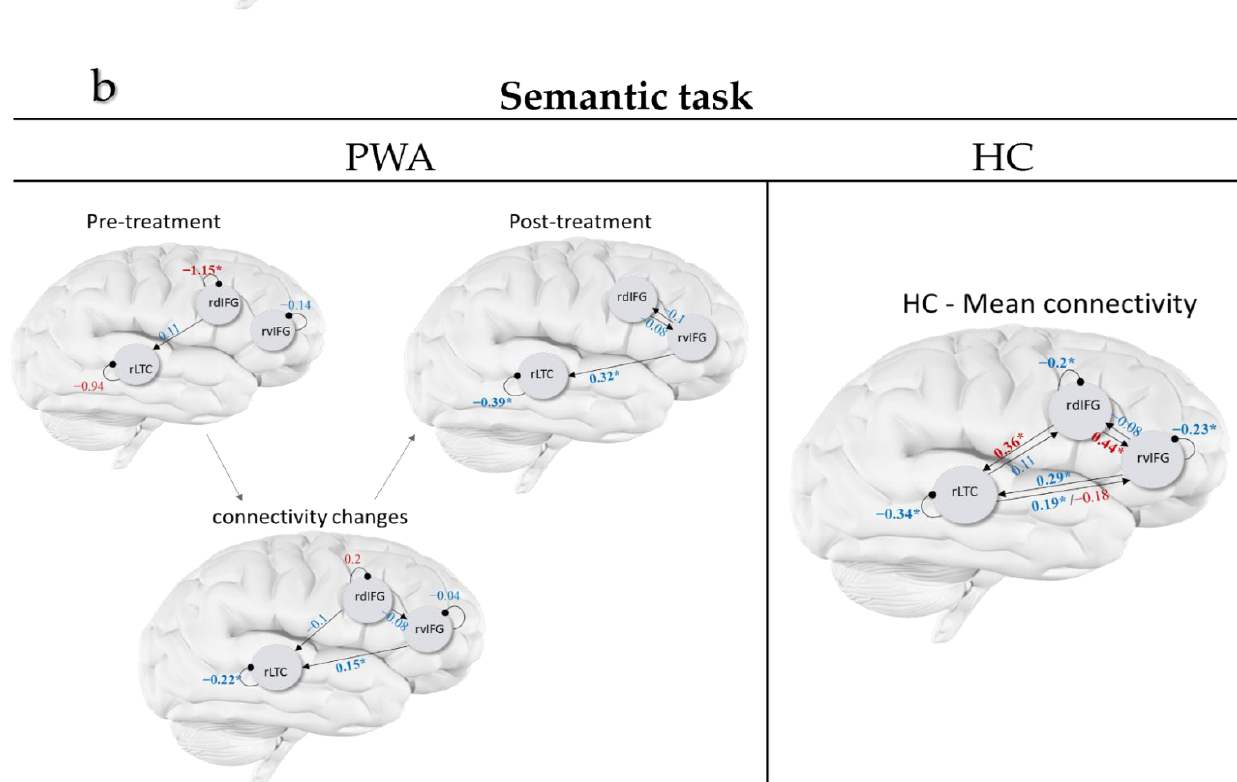
Figure 2. Connectivity after BMR in people with aphasia (PWA; pre-treatment, post-treatment, and changes from pre to post-treatment) and connectivity in healthy controls (HC; averaged across the two scans). Results are shown for the phonological ( a ) and semantic tasks ( b ). Black arrows represent connection direction. Numeric values represent connections strength (in Hz for extrinsic connection and in unitless log-scaling for intrinsic connection), or the change in strength from pre- to post: blue values for averaged connectivity (A matrix) and red for the modulatory effect of the linguistic condition (B matrix). Bolded starred values (*) are connections with probability >0.9.